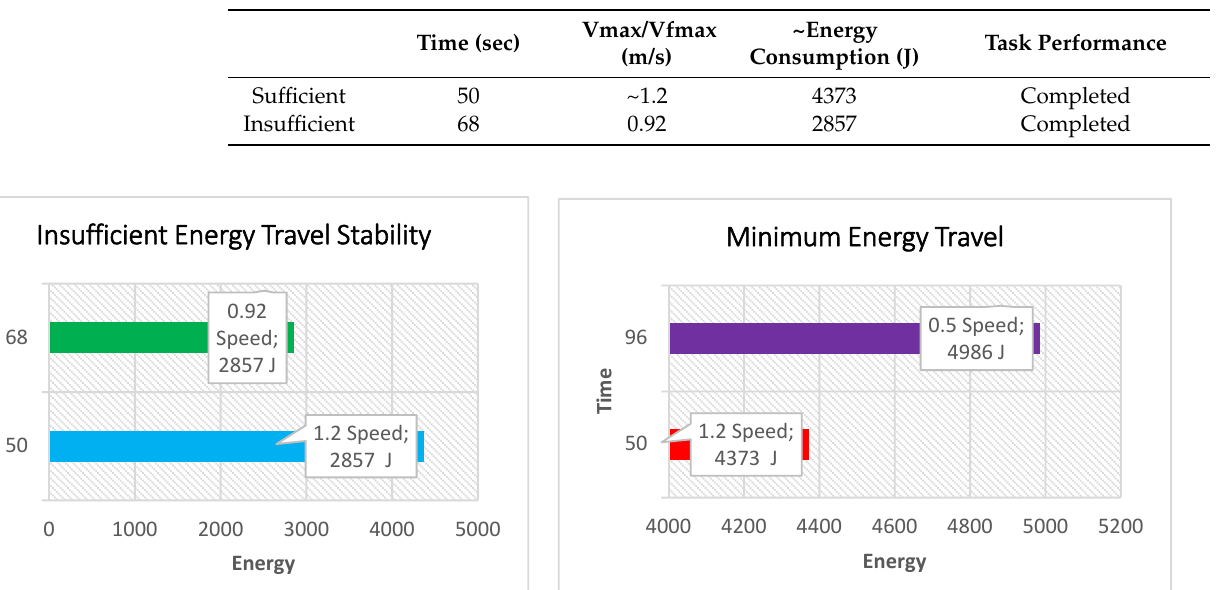
Table 7. Insufficient energy travel stability .